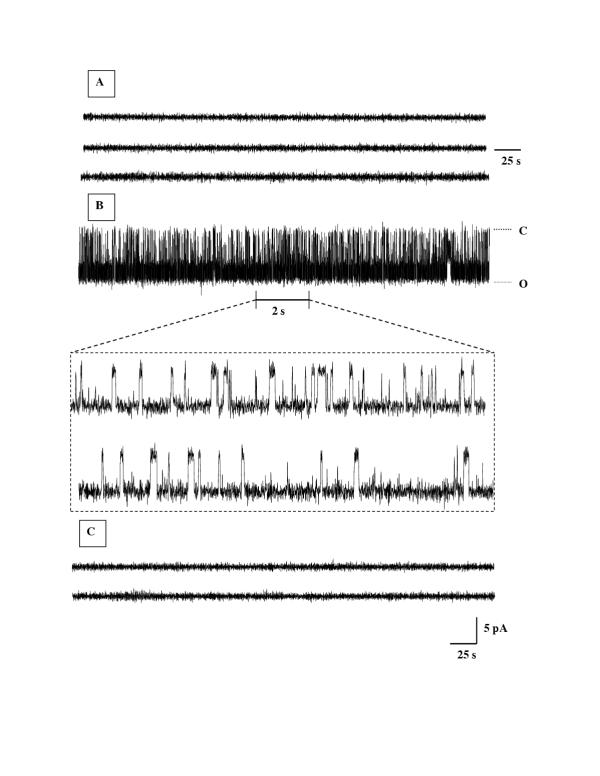
Single channel recording of the activity of the putative L-ArgR in planar lipid bilayers. Proteoliposomes containing protein from the first peak fractions off the Sephacryl S-300 elution were fused to planar lipid bilayers (DOPS:DOPE, 1:1) as described in Methods. (A). An initial control trace was obtained after addition proteoliposomes to the membrane bathing solution, before the addition of L-Arg. The three rows are from a continuous recording. (B). The addition of 10 μM L-Arg to the cis-side of the bilayer evoked regular periodic channel activity. A portion of this current record is shown at an expanded scale. (C). After several minutes of recording, the addition of 100 μM D-Arg to the cis-side resulted in the cessation of activity. Transmembrane potential was -100 mV. Traces shown in all panels are continuous records of that specific condition.